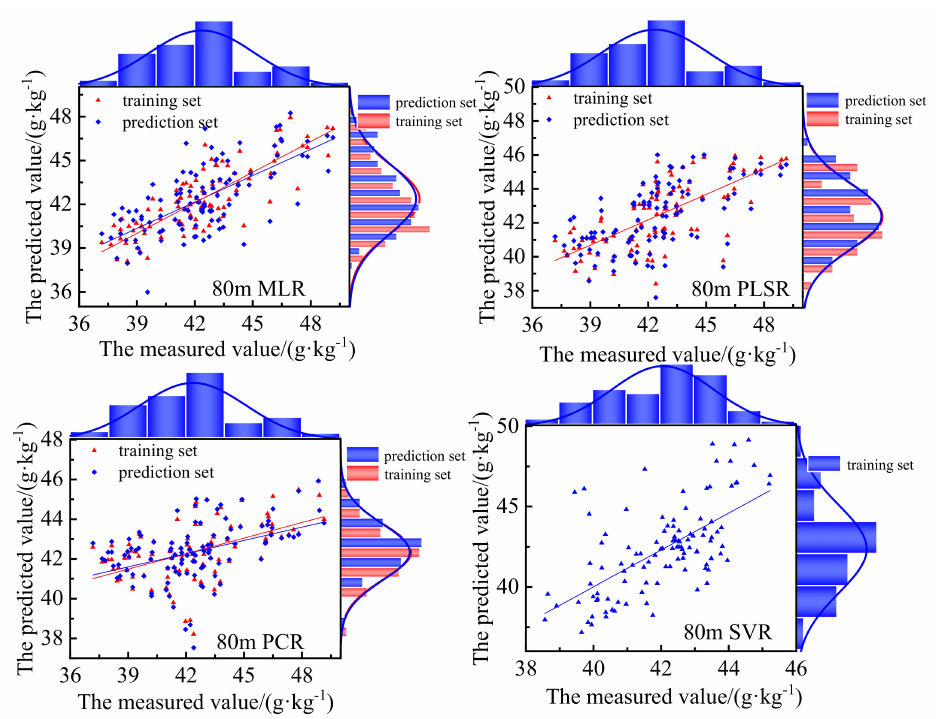
Figure 15. Scatterplots of the measured LNC vs. predicted LNC using multiple modeling methods (80 m).